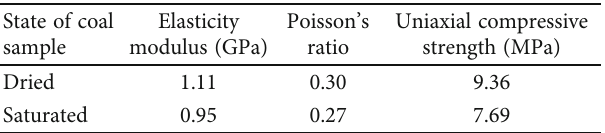
Figure 7: Frequency domains for the three adjacent faces of the saturated lignite coal sample. Table 3: Mechanical parameters of dried and saturated lignite coal